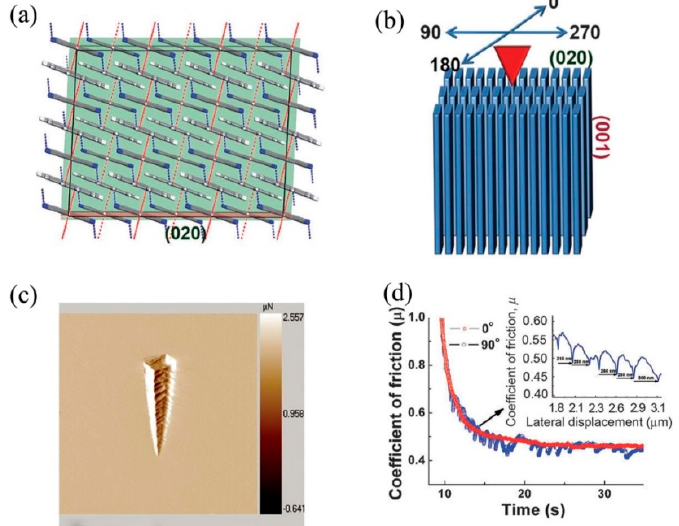
Figure 18. TCNB–phenanthrene complex. ( a ) Crystal packing. ( b ) Schematic representation of the indenter movement along different directions and layer arrangement of the (020) face. ( c ) AFM image with a scan size of 25 µm, showing layer resistance towards the indenter movement and a limited pile-up at the end of the scratch track, and ( d ) The coefficient of friction at 0° and 90° shows distinct scratching behavior. The inset shows the inhomogeneous travel of the indenter during scratching against molecular layers. (Reproduced with permission from Wiley-VCH, Reference 108).